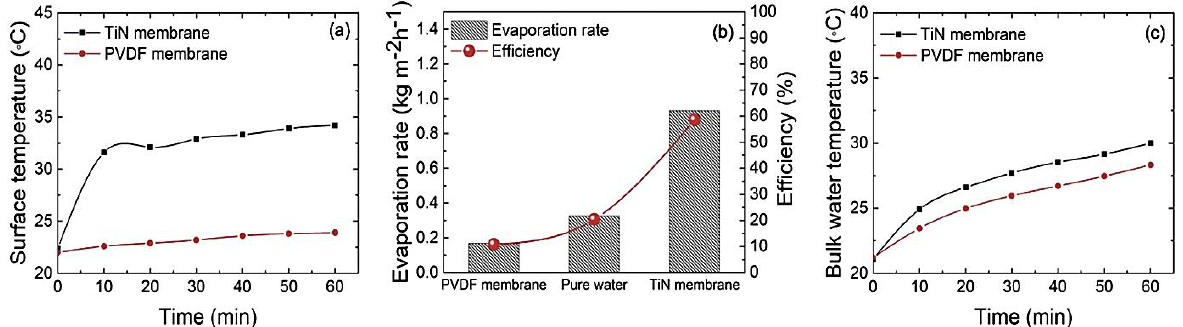
Figure 9. Comparing the solar vapor generation performance of TiN and PVDF membranes with the amount of vapor generated by leaving a sample of freshwater under sunlight: ( a ) dependence of the membrane’s surface temperature to the duration of exposure to sunlight; ( b ) evaporation rates and efficiencies for various setups; and ( c ) dependence of the temperature of the bulk water to the duration of exposure to sunlight. Reprinted with permission from [98]. Copyright © 2020, Elsevier.